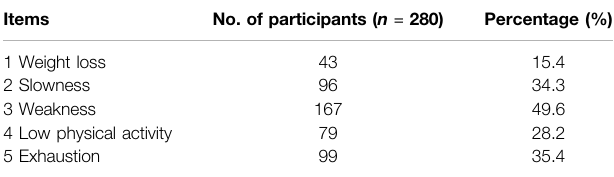
TABLE 3 | | Fried for inpatients with CHD ( N (cid:1) 280).